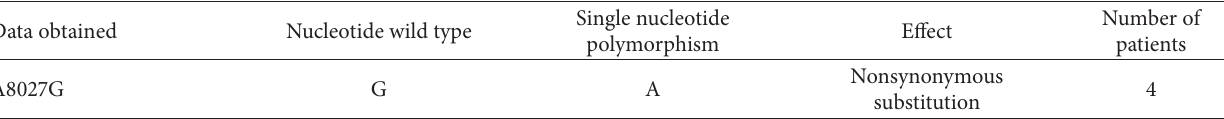
Table 1: Polymorphism A8027 in Alzheimer’s disease